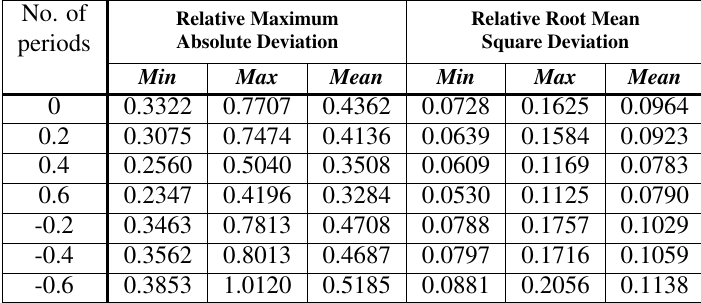
TABLE IV. Relative Maximum Absolute Deviation